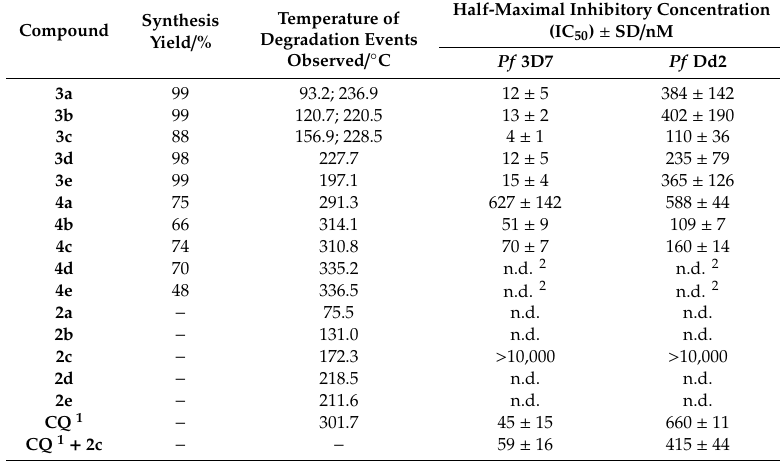
Table 1. Synthesis yields, thermal degradation data, and in vitro activity against Plasmodium falciparum ( Pf ) 3D7 and Dd2 strains obtained for room temperature ionic liquids (RTILs) 3a – e and for their covalent analogues 4a – e ; thermal degradation data also provided for CQ phosphate and 2a – e ; the in vitro activity data obtained for the commercial CQ phosphate salt, for 2c , and for an equimolar mixture of these two compounds are also included. Temperature of Compound Synthesis Degradation Events Yield / % Observed / ◦